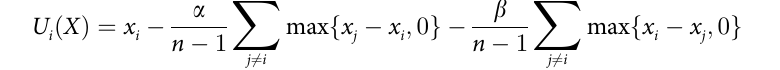
S1 Fig. Reaction-time histograms and quantile-utility plots for Tasks 1 – 4 respectively, pooling all of the data from each task. In the histograms, black circles indicate the subject means with standard error bars clustered by subject. Red dashed lines indicate the aDDM pre- dictions. In the quantile-utility plots, circles indicate the aggregate subject data and lines indi- cate the DDM predictions ( θ = 0.3) with lighter shading showing 95% confidence intervals from the simulations. Black, red, blue, green and gray colors indicate the 10%, 30%, 50%,